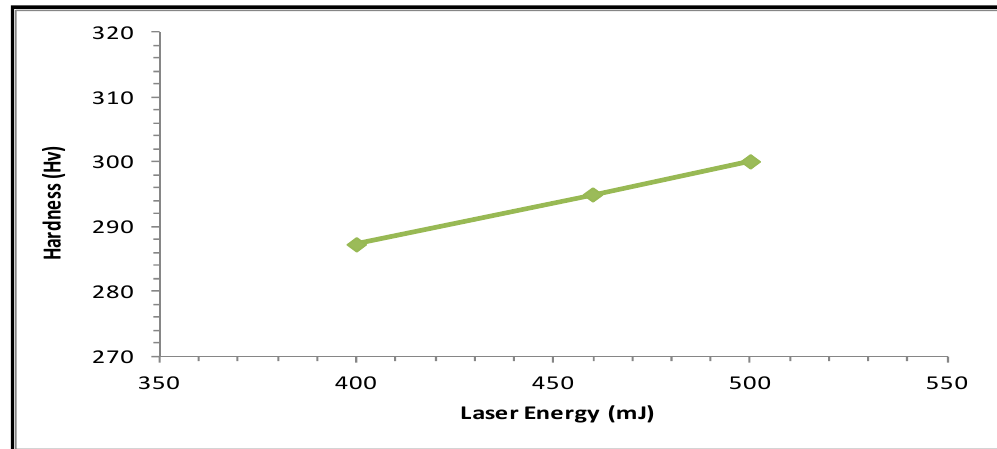
Fig.9: The hardness value with laser energy at spraying distance (12 cm).